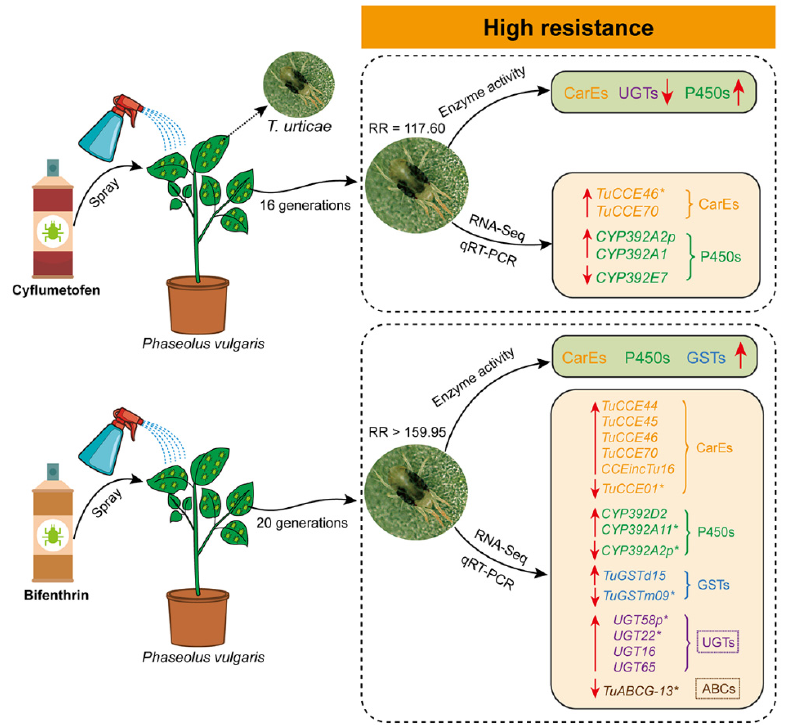
Figure 10. The integrated diagram illustrating the changes of detoxifying enzymes and involved genes in the cyflumetofen ‐ and bifenthrin ‐ resistant T. urticae strains based on this study. The up and down arrows indicate the increased/up ‐ regulated and decreased/down ‐ regulated of the parameters, respectively.